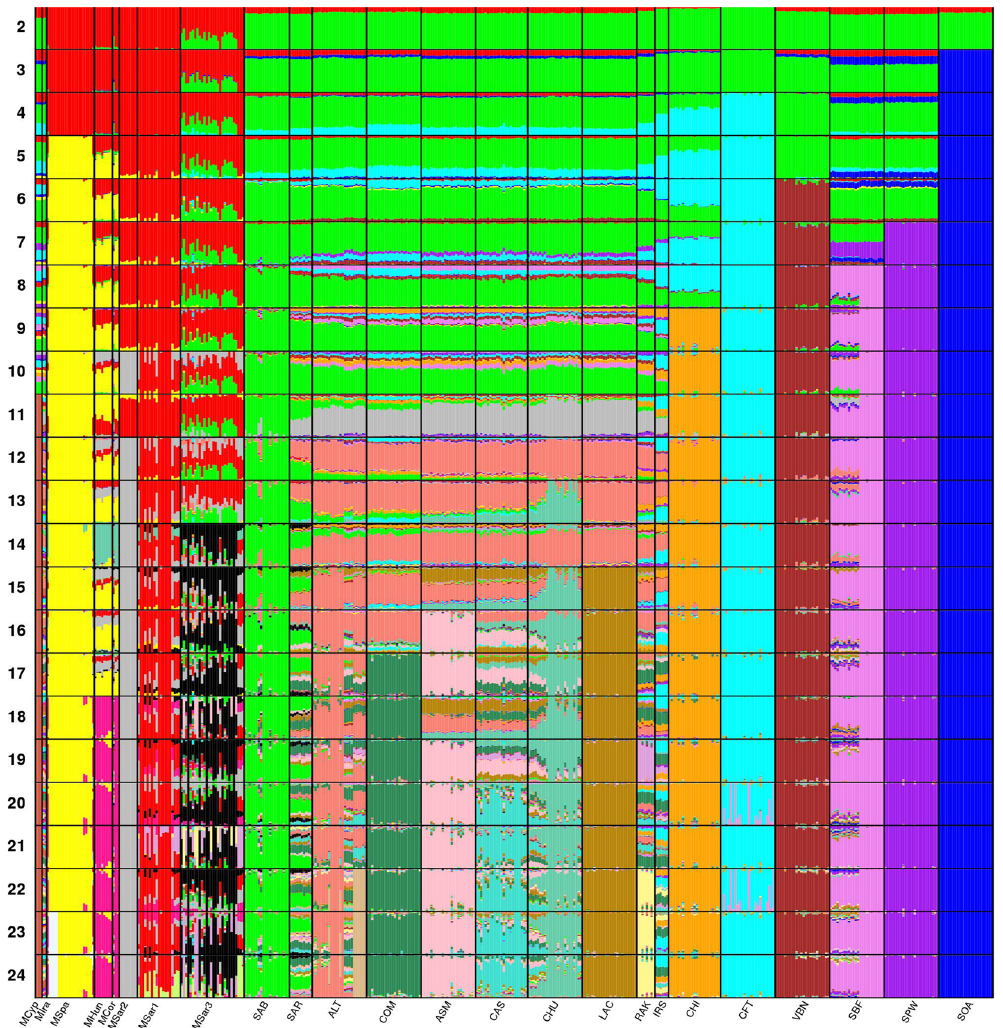
Figure 2. Admixture plot. Admixture plot comprising the first 24 clustering solutions of all the 422 individuals analysed in this work. The analysis is based on 36,961 SNPs from the Ovine SNP50BeadChip. For population abbreviations see Table